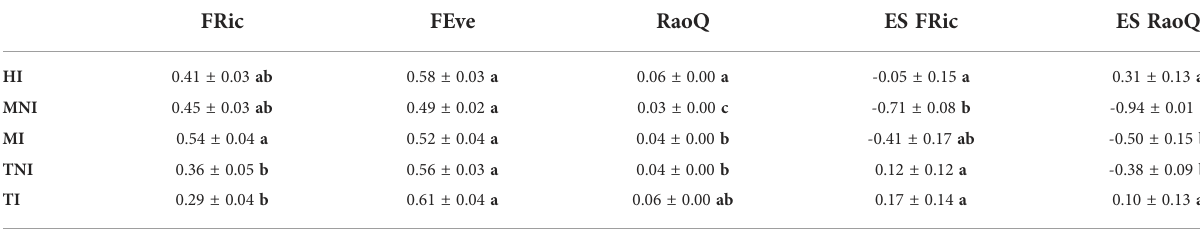
TABLE 3 Mean values (± SE) by plots of functional diversity indices based on the interaction of weed management and irrigation (WM:I). FRic FEve RaoQ